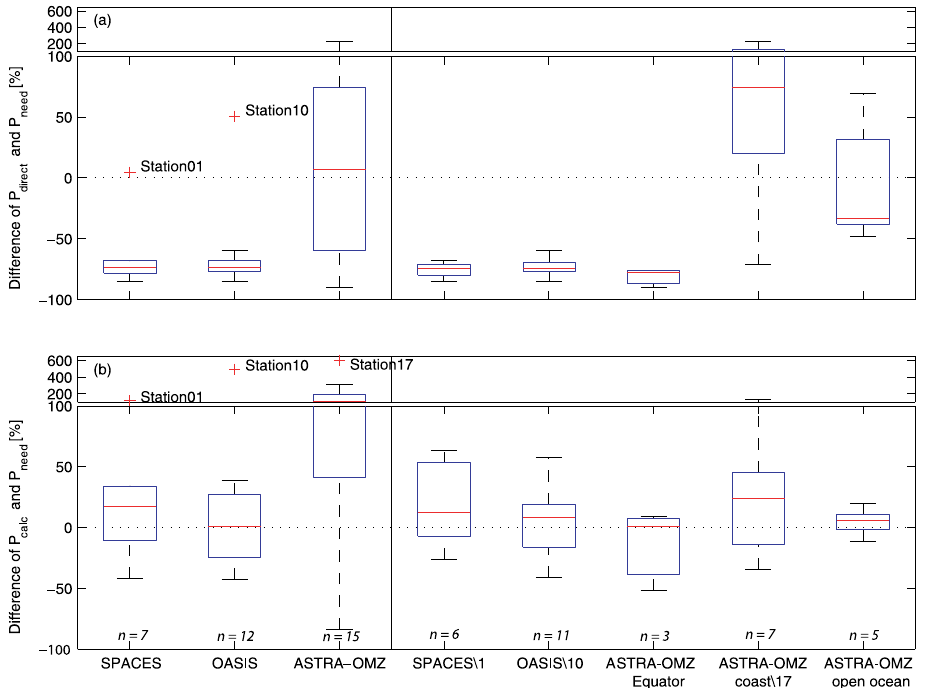
Figure 5. Percent differences between (a) P direct and P need ( (P direct − P need )/P need ) and (b) P calc and P need ( (P calc − P need )/P need ) for the different cruises/cruise regions. Left of the vertical black line, data are divided into the three different cruises; right of the vertical black line, data are shown for the three cruises with outliers from the left part excluded. Additionally, ASTRA-OMZ was split into three regions (Equator, coast, open ocean). Number of stations (n) used for each set of data are shown in italics. The red line represents the median, the boxes show the first to third quartile, and the whiskers illustrate the highest and lowest values that are not outliers. The red plus signs represent outliers. The number indicated after \ denotes a station that has been excluded from the analysis. Table 3. Calculated chl- a -normalized isoprene production rates ( P chloronew , µmol(gchl a ) − 1 day − 1 ) of the three most abundant PFTs dur- ing SPACES and OASIS (haptophytes, cyanobacteria, Prochlorococcus ) and ASTRA-OMZ (haptophytes, chlorophytes, diatoms). Number indicated after \ denotes a station that has been excluded from the analysis. For explanation of the omission, please refer to Sect. 3.3. Cruise Haptophytes Cyanobacteria Prochlorococcus Chlorophytes Diatoms SPACES \ 1 0.5 OASIS \